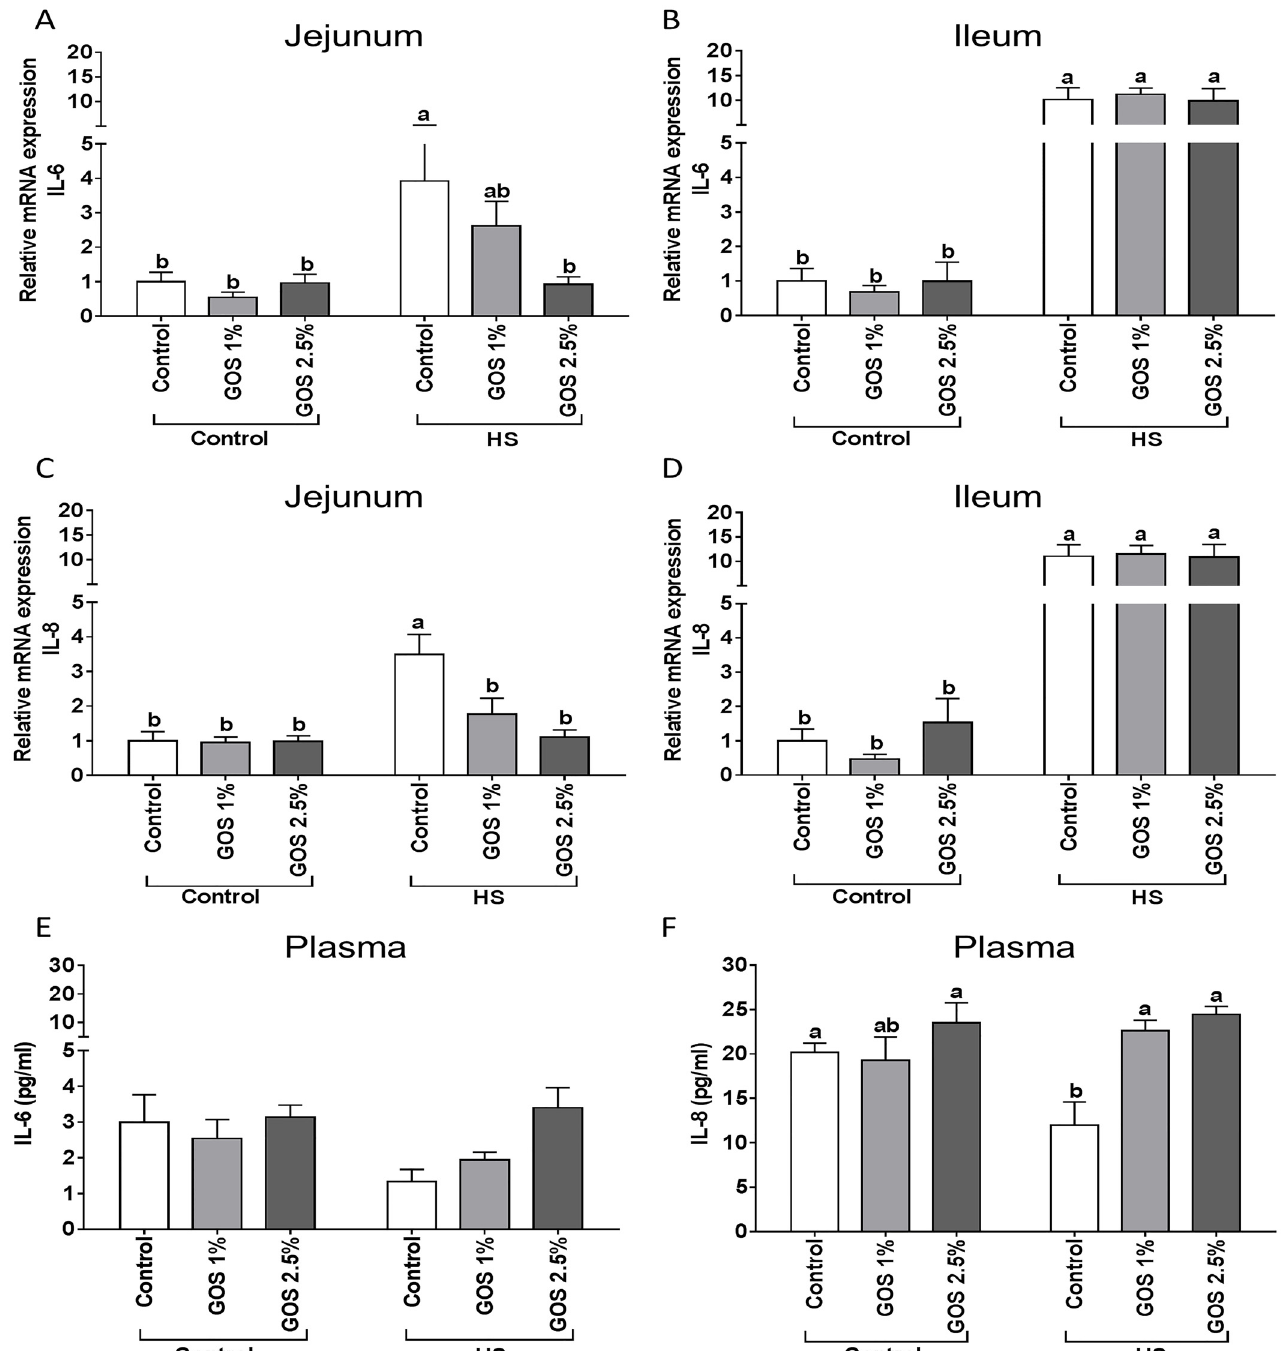
Fig 5. The effect of heat stress exposure on the IL-6 and IL-8 plasma levels and mRNA expression in jejunum and ileum of chickens fed a control or GOS diet. Chickens fed a control or GOS (1 or 2.5%) diet for 6 days before being exposed to either control or heat stress conditions for 5 days. mRNA expression of IL-6 (A, B) and IL-8 (C, D) in jejunum (A, C) and ileum (B, D) evaluated by qRT-PCR. Results are expressed as relative mRNA expression (fold of control, normalized to β -actin) as mean ± SEM. IL-6 (E) and IL-8 (F) secretion in plasma determined by ELISA. Results are expressed in pg/ml as mean ± SEM. n = 6 – 10 animals/experimental group. Different lowercase letters denote significant differences among